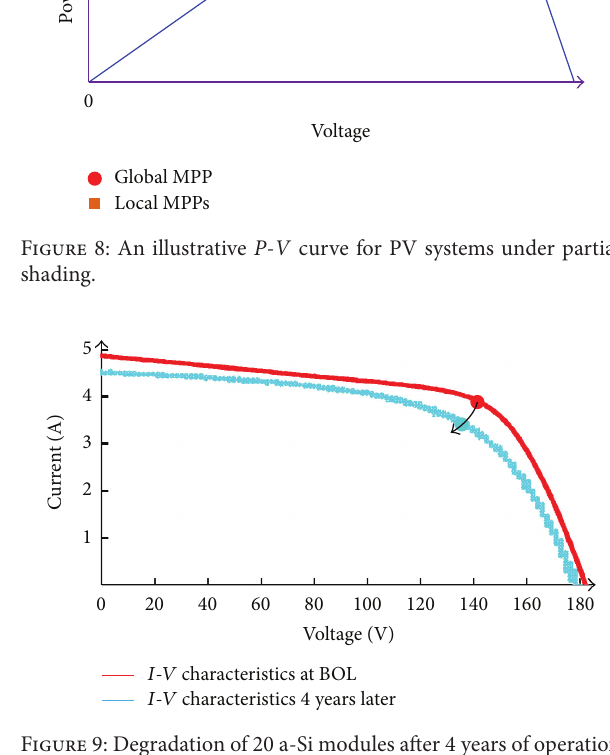
Figure 9: Degradation of 20 a-Si modules after 4 years of operation in